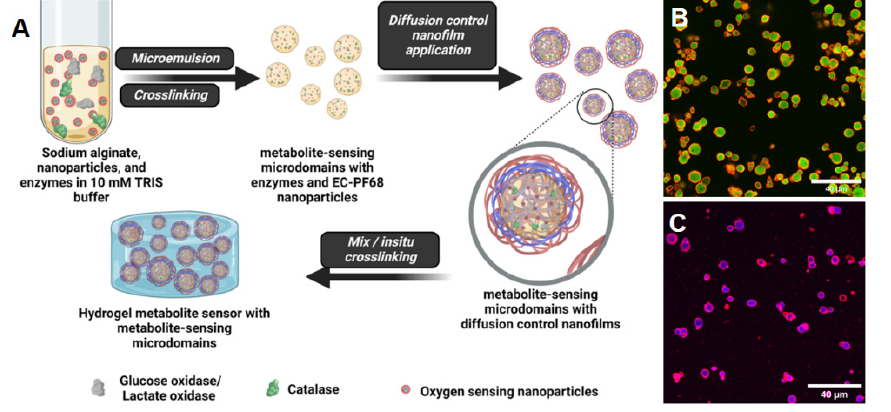
Figure 7. ( A ) Synthesis of glucose and lactate-sensing microdomains encapsulating glucose oxidase or lactic acid oxidase, catalase, and EC-PF68 NPs. The micro-reactors are coated with polyelectrolyte multilayer glucose diffusion control nanofilms by layer-by-layer sequential deposition method. Finally, the microreactors are dispersed in calcium alginate hydrogels to obtain the hydrogel glucose or lactate sensors. Confocal fluorescence composite image of ( B ) glucose sensors with GOx and EC-PF68 NPs in the core (yellow) and diffusion control nanofilms (red) ( C ) Lactate sensors with LOx and EC-PF68 NPs in the core (blue) with fluorescent labeled diffusion control nanofilms (red). Scale bar on panels B and C is 40 µ